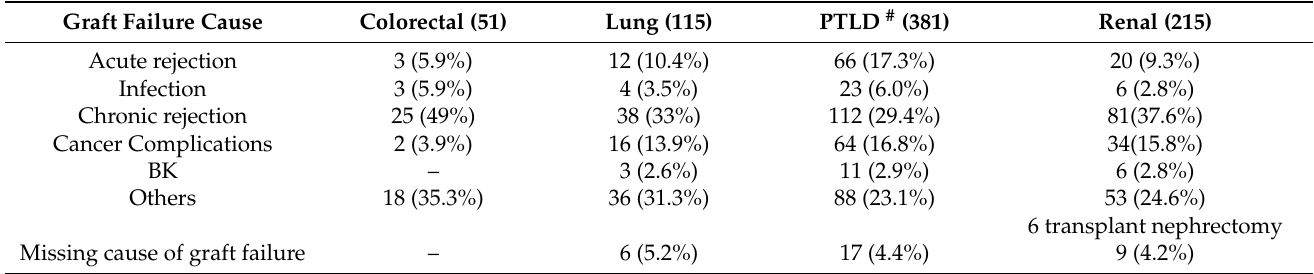
Table 4. Cause of graft failure.